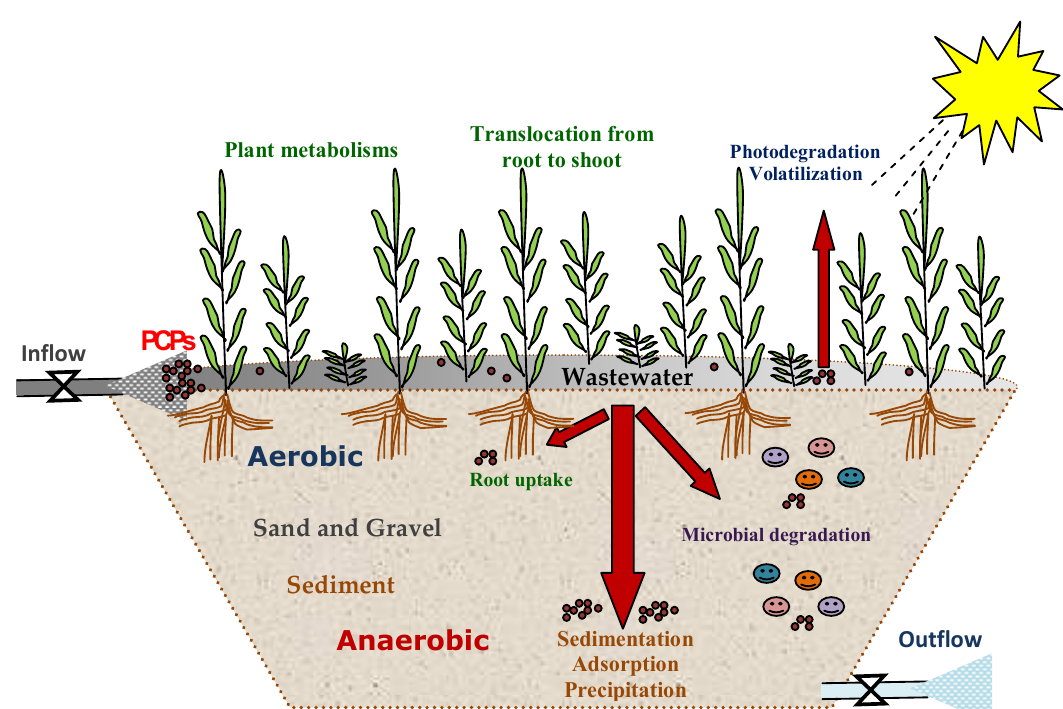
Figure 1. A schematic representation of the removal mechanisms of personal care products (PCPs) in constructed wetlands (CWs). Table 4. Removal mechanisms of 15 widely studied PCPs in